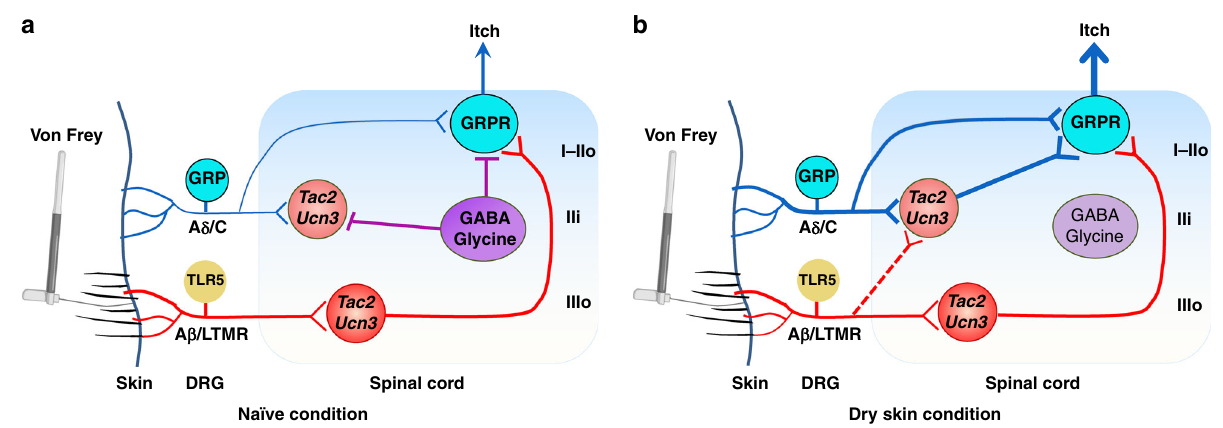
Fig. 9 Schematics showing the spinal neural circuitry for touch-to-itch conversion. a Under naive condition, Tac2/Ucn3 tdTom neurons in lamina IIIo receive innocuous light touch information via LTMR A β /TLR5 fi bers directly and in turn relay the touch information to GRPR neurons in laminae I – IIo, which convert it to itch. By contrast, Tac2/Ucn3 tdTom neurons in lamina IIi which receive direct inputs from C/A δ fi bers and indirect A β inputs may remain silent or inactive resulting from feedforward inhibition of GABAergic/glycinergic neurons. b Under dry skin itch condition, GRP primary afferents convey chemical itch information via GRP to GRPR neurons directly. In addition, enhanced chemical itch relayed by C/A δ fi bers recruit IIi Tac2/Ucn3 tdTom neurons to relay chemical itch information to GRPR neurons. Light touch information conveyed by Tac2/Ucn3 tdTom neurons, along with newly recruited IIi Tac2/Ucn3 tdTom neurons, and chemical itch converge on GRPR neurons. Augmented activity of GRPR function can also be resultant from reduced or a loss of feedforward inhibition mediated by GABAergic/glycinergic neurons, giving rise to exacerbated chronic itch and